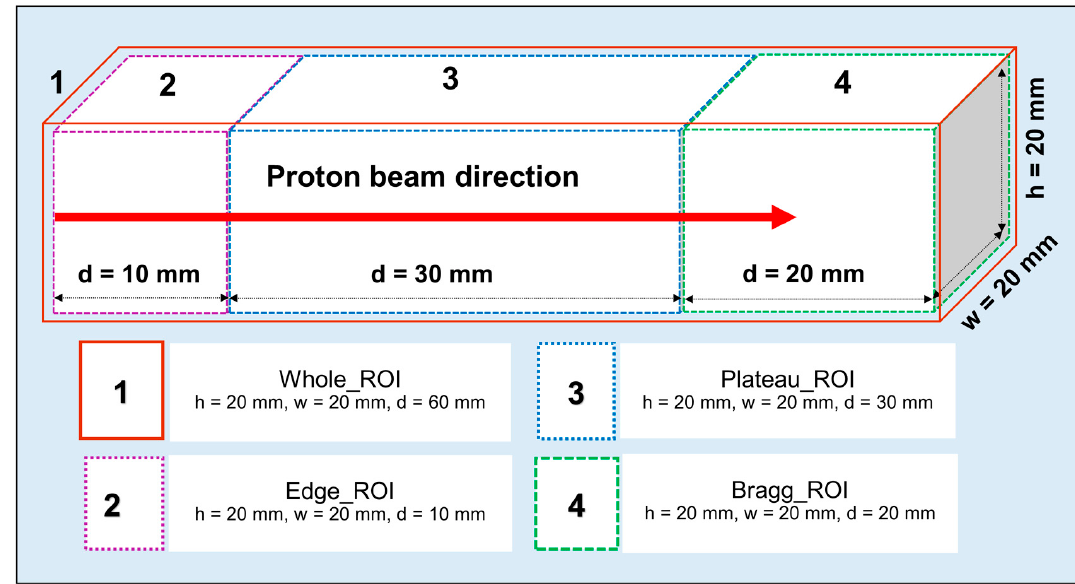
Figure 3. An illustration of the four regions of interest (ROIs) and their height ( h ), width ( w ) and depth ( d ) values used in SA technique.